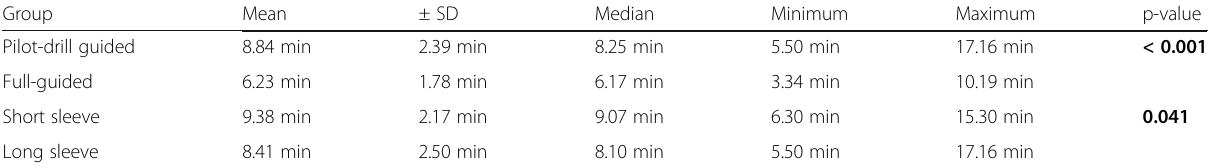
Table 4 Comparison of the time required for implant insertion for pilot-drill guided and full-guided implant insertion. For the pilot-drill guided implant insertion, the times are itemized for short and long sleeves. The means, their standard deviations (SD), medians, minima and maxima are shown. The p-values are resulting from a pair-wise comparison. The p-values for statistically significant differences are marked in bold